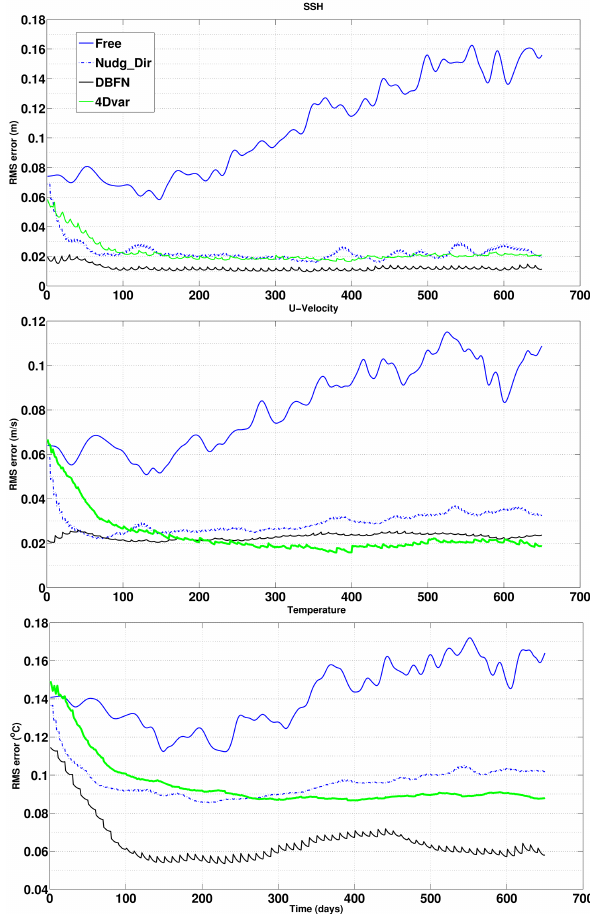
Figure 7. Forecast rms errors on SSH (top panel), zonal velocity (middle panel) and temperature (bottom panel) from DBFN, 4Dvar, ONDG (Nudg_dir) and the free run. The DAw is 10 days.